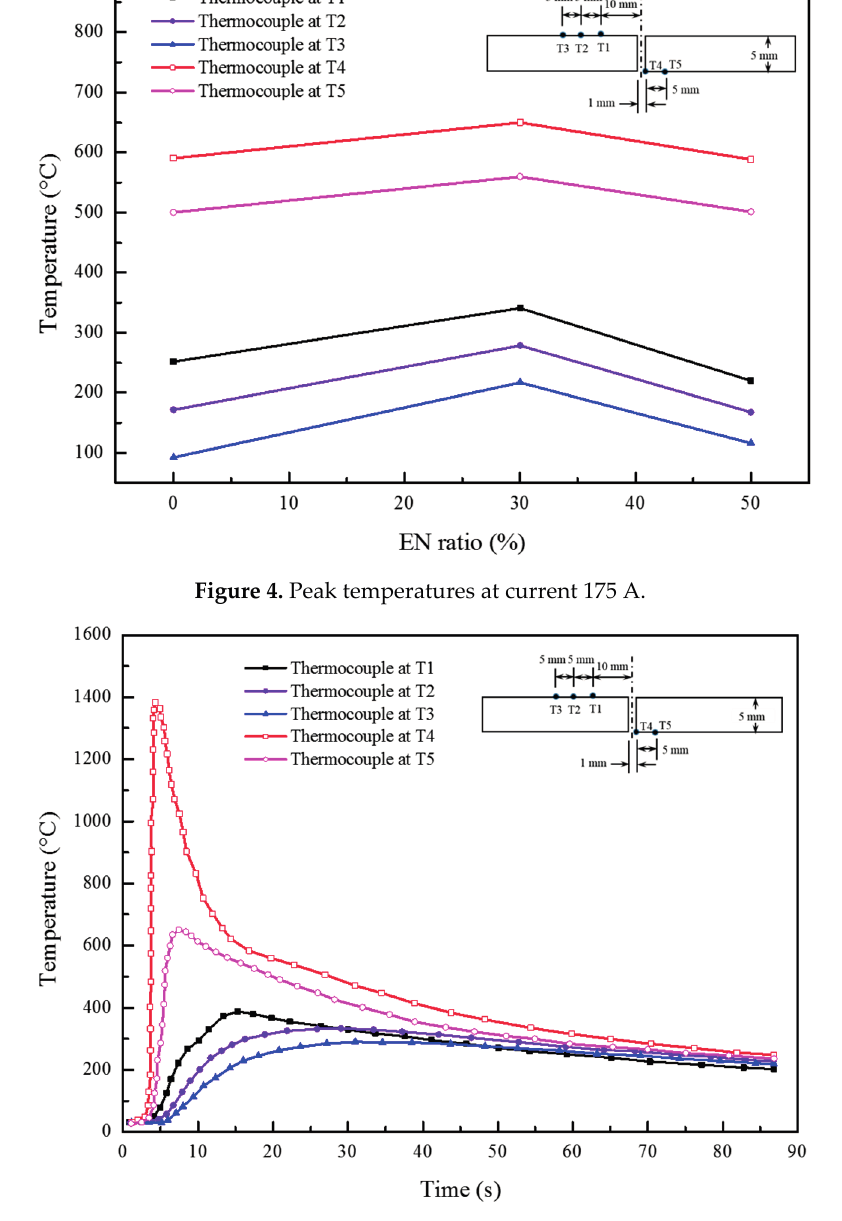
Figure 5. Thermocouple temperatures at current 250 A and 50% EN